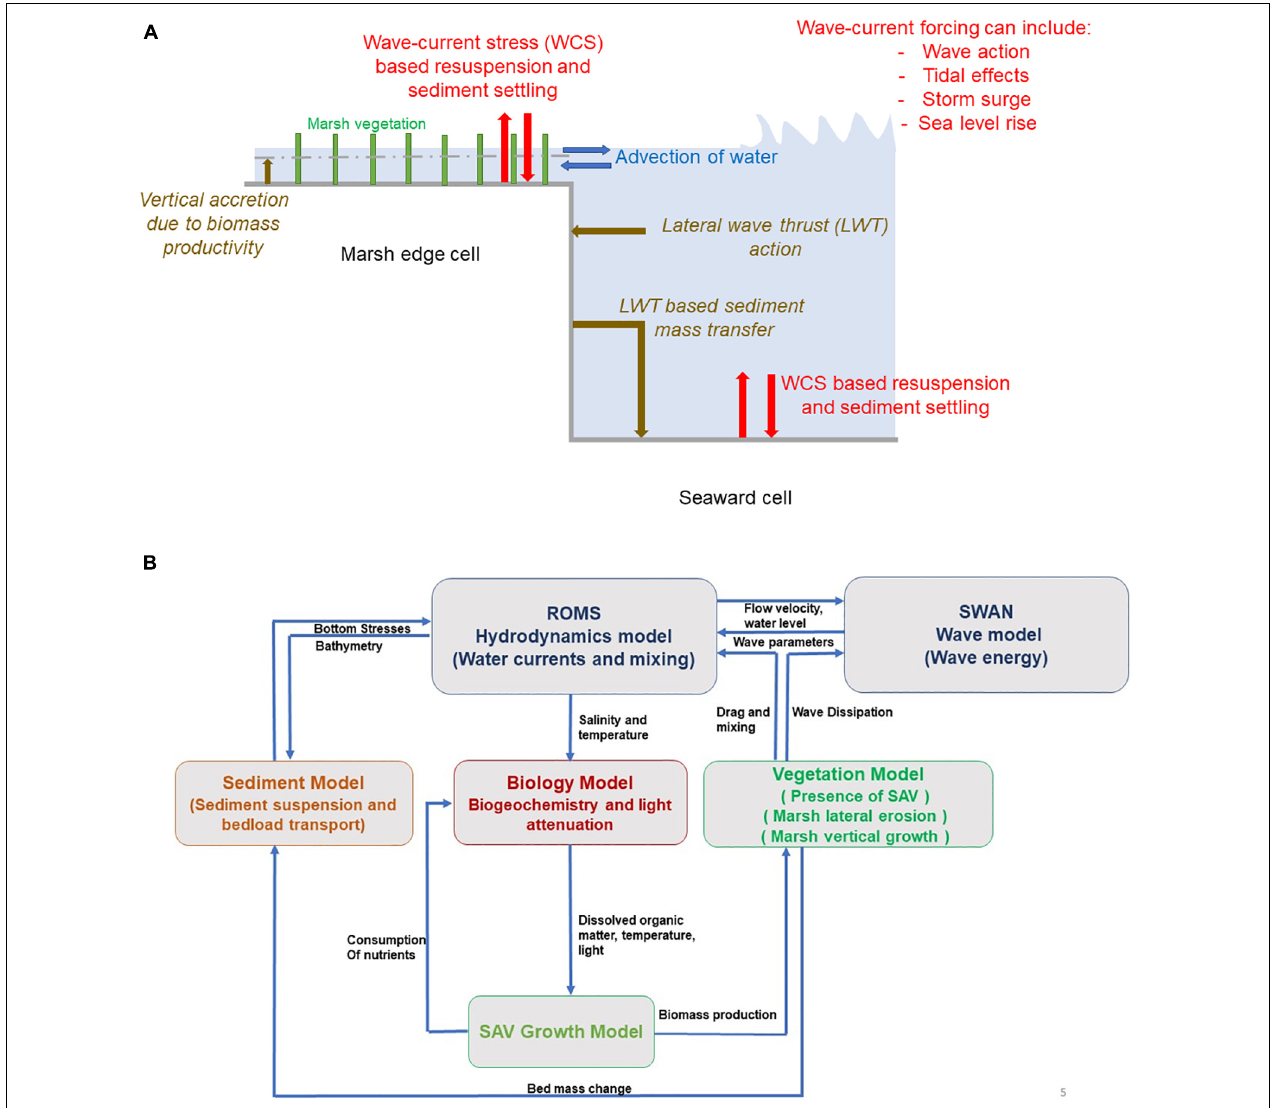
FIGURE 1 | Schematic showing the incorporation of marsh dynamics (lateral wave thrust based erosion and vertical accretion due to biomass production). (A) Newly added processes in the model are shown with brown fonts and brown arrows, (B) flowchart showing the incorporation of the newly added routines within vegetation module in the COAWST